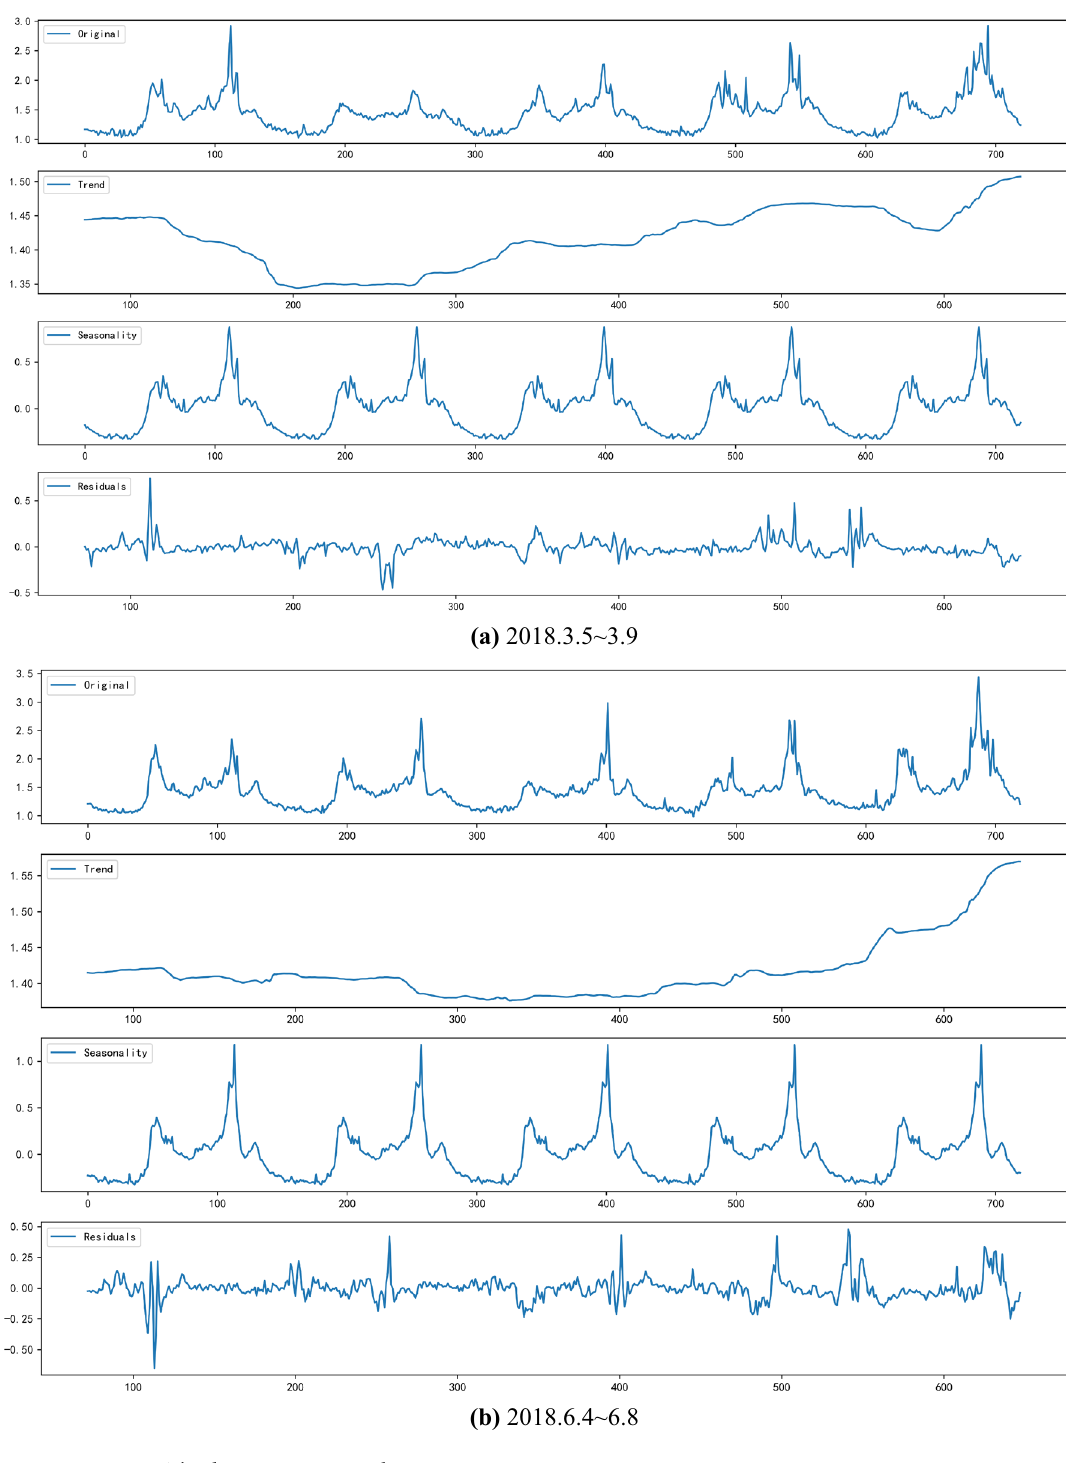
Figure 4. The decomposition